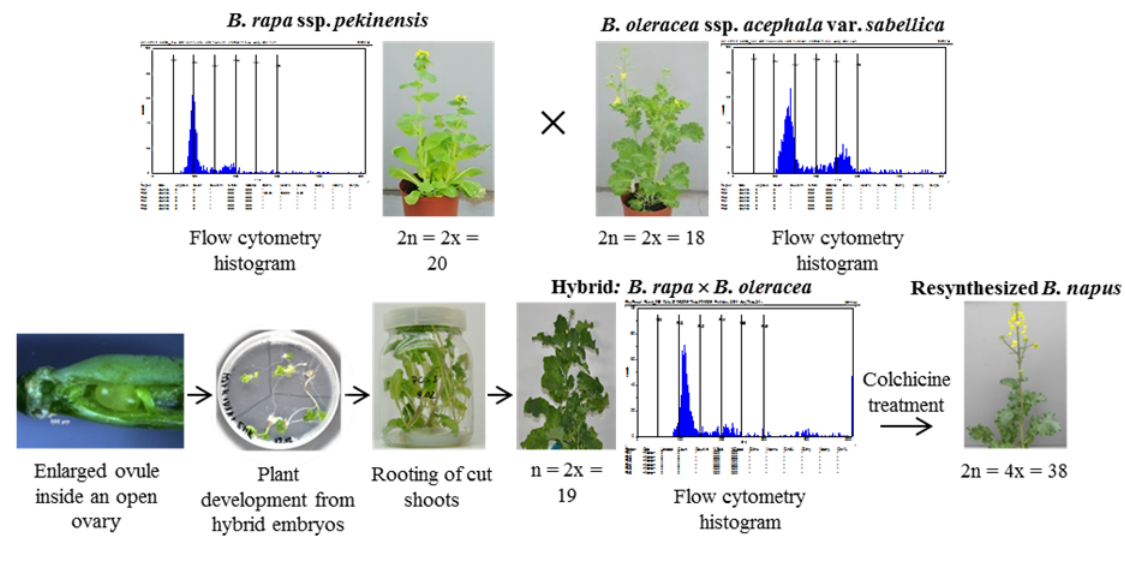
Figure 1 Resynthesis of Brassica napus L. using Chinese cabbage ( Brassica rapa ssp. pekinensis ) and curly kale ( Brassica oleracea ssp. acephala var. sabellica ). Histograms in the scheme show nuclear DNA content, with x -axis showing relative DNA content and y -axis showing the number of nuclei. All photographs are retrieved from the archives of the Department of Oilseed Crops, Plant Breeding and Acclimatization Institute – National Research Institute,